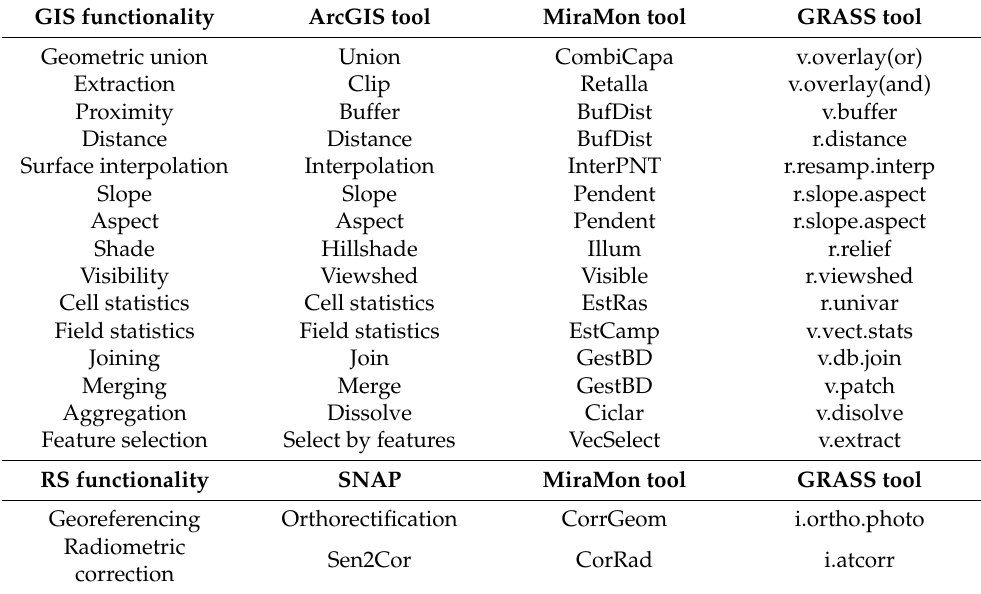
Table 1. Some Geographic Information System (GIS) and Remote Sensing (RS) functionalities with the different names in the ArcGIS, MiraMon, GRASS, and SNAP